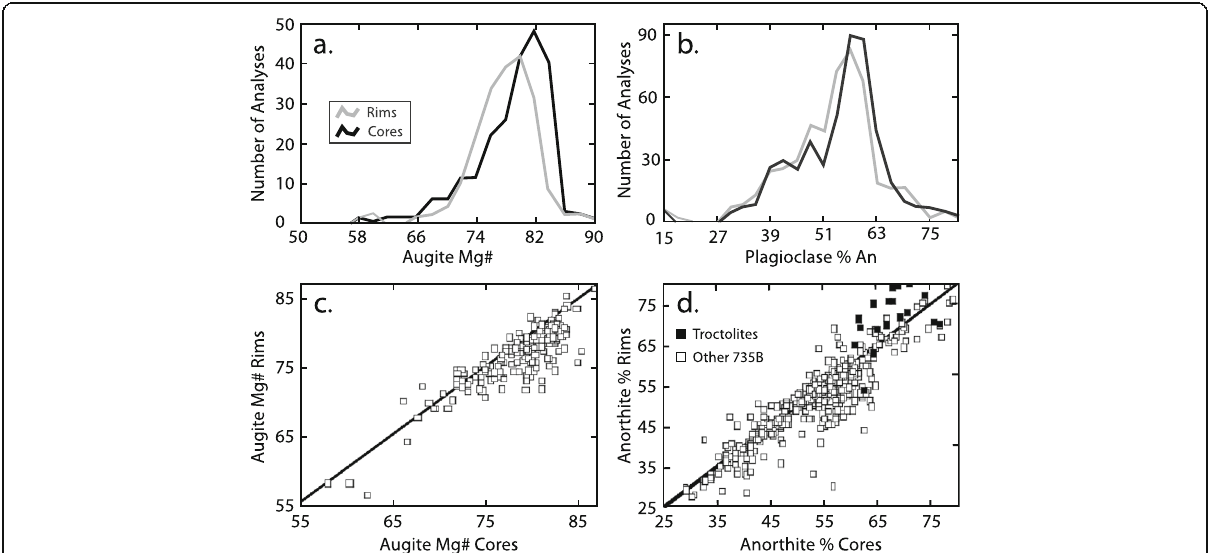
Fig. 14 Core and rim compositions in Hole 735B augite Mg# and plagioclase anorthite content. a , b Distribution plots for augite and plagioclase cores and rims, respectively. Data are from Dick et al. (2001), and Angeloni and Dick (1990) for troctolite dikes in the upper 550 m of the hole. c , d Plots of core vs rim Mg# ’ s for augite and core and rim anorthite percent for plagioclase. Black lines show 1:1 proportion of augite Mg# (100 × Mg/ [Mg + Fe]) and plagioclase anorthite content. Except for the troctolites, core-rim data are not generally available for the upper 550 m of Hole